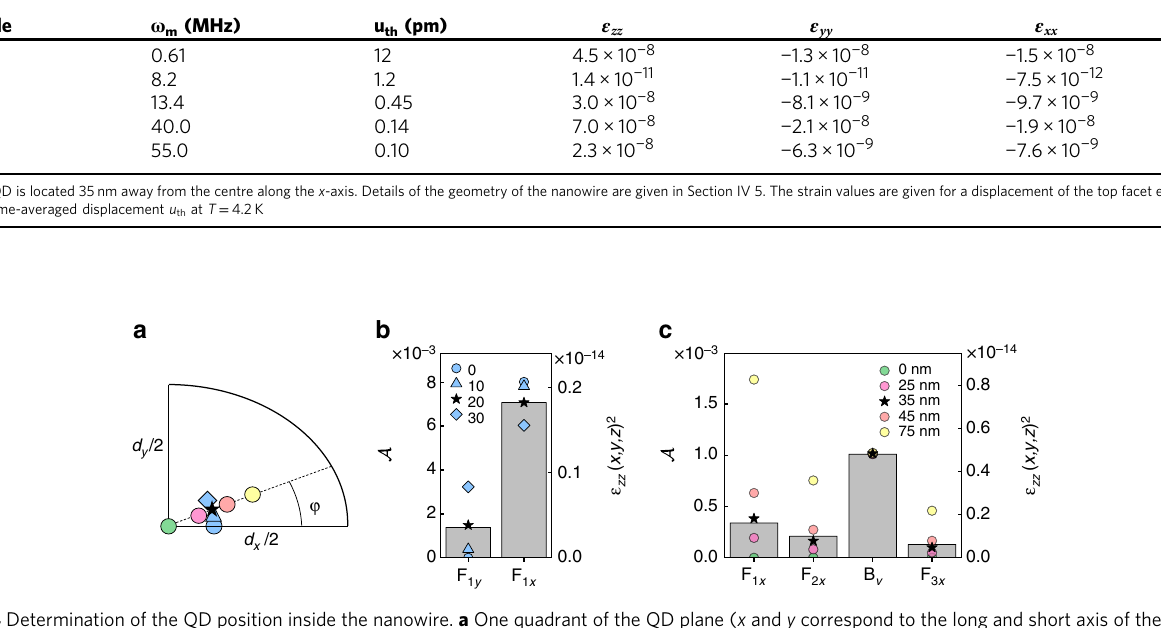
Table 1 Simulated strain for a QD on the x axis for the different mechanical modes Mode